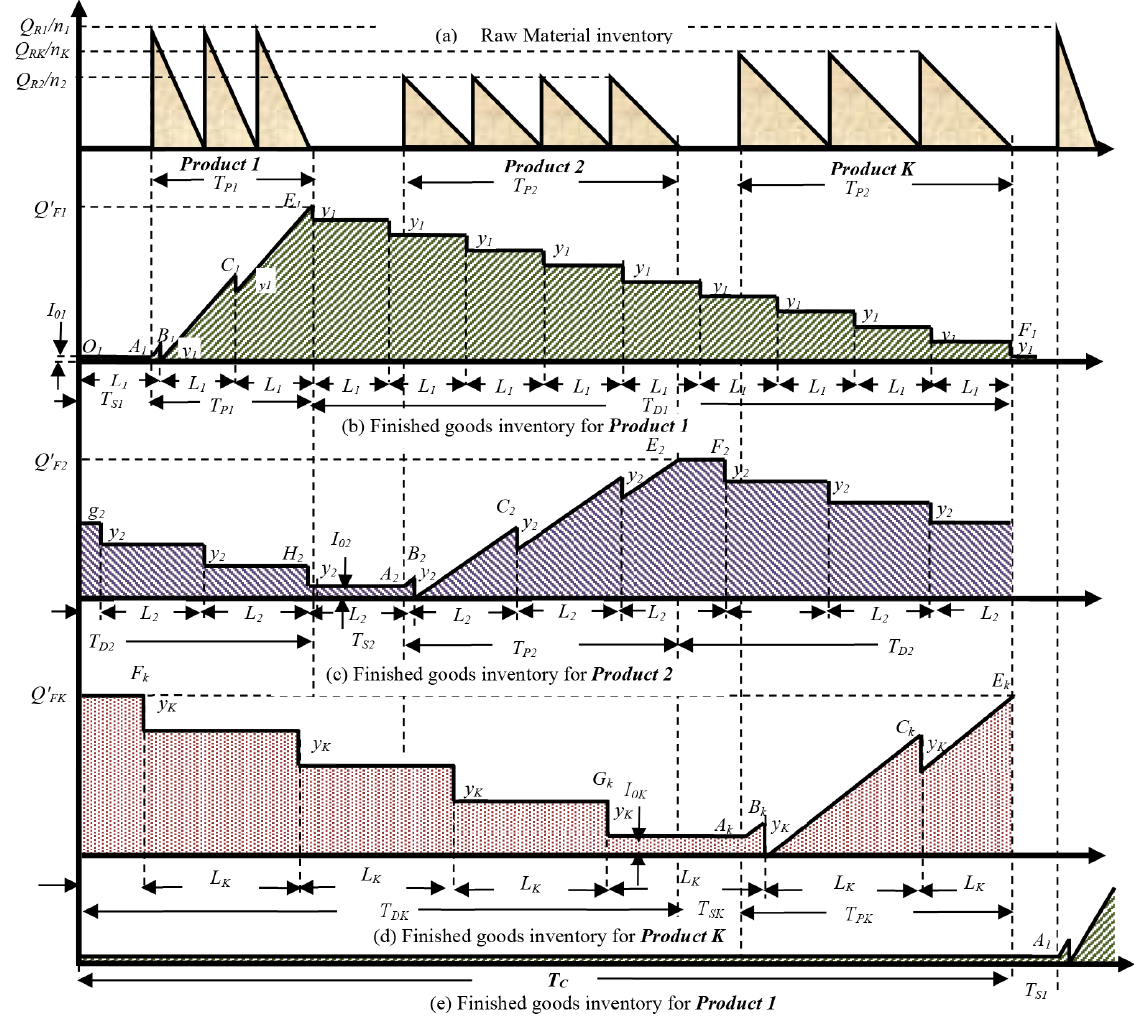
Figure 6. Rotational cycle inventory